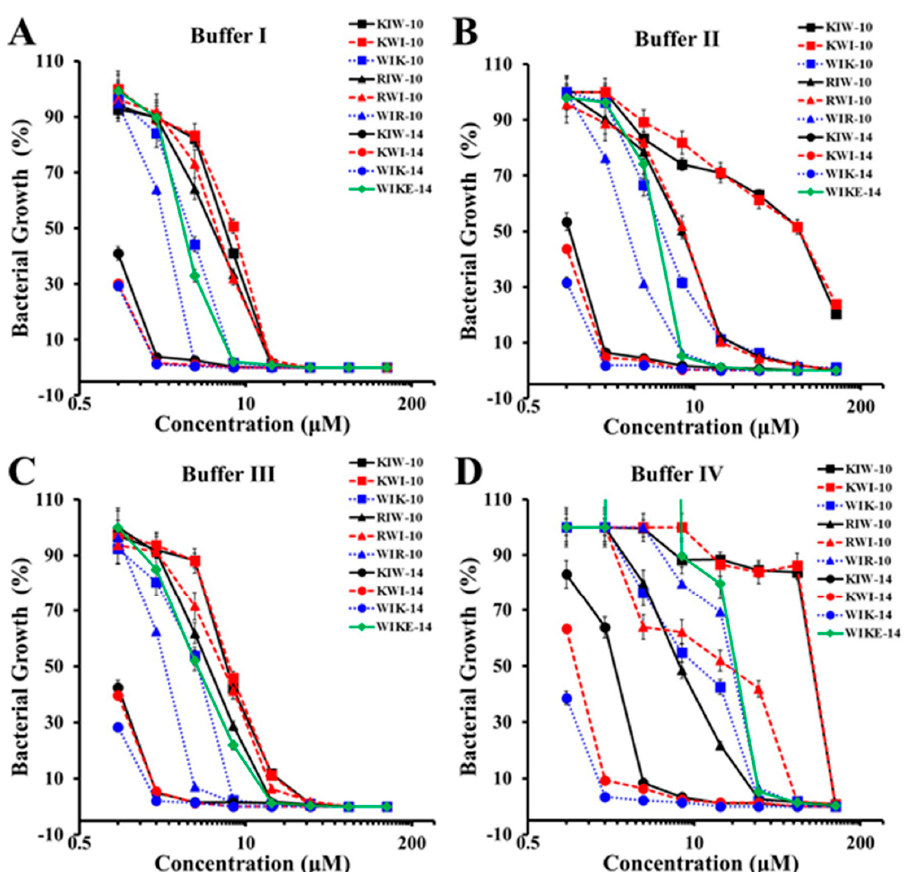
Figure 1. Antibacterial activity of peptides in different ionic buffers against DRPa 4007. ( A ) Buffer I: 10 mM HEPES, 10 mM NaCl, pH 7.4 + 10% MH; ( B ) buffer II: 10 mM HEPES, 150 mM NaCl, pH 7.4 + 10% MH; ( C ) buffer III: 10 mM HEPES, 5 mM MgCl 2 , pH 7.4 + 10% MH; ( D ) buffer IV: 10 mM HEPES, 150 mM NaCl, 5 mM MgCl 2 , pH 7.4 + 10% MH.